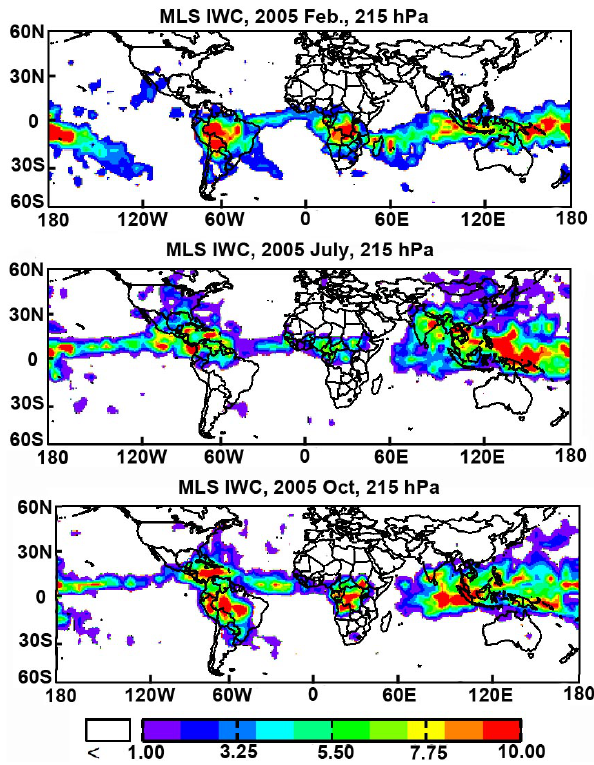
Fig. 3. MLS ice water content (IWC) (gm − 3 ) at 215hPa in Febru- ary (top), July (middle) and October (bottom)